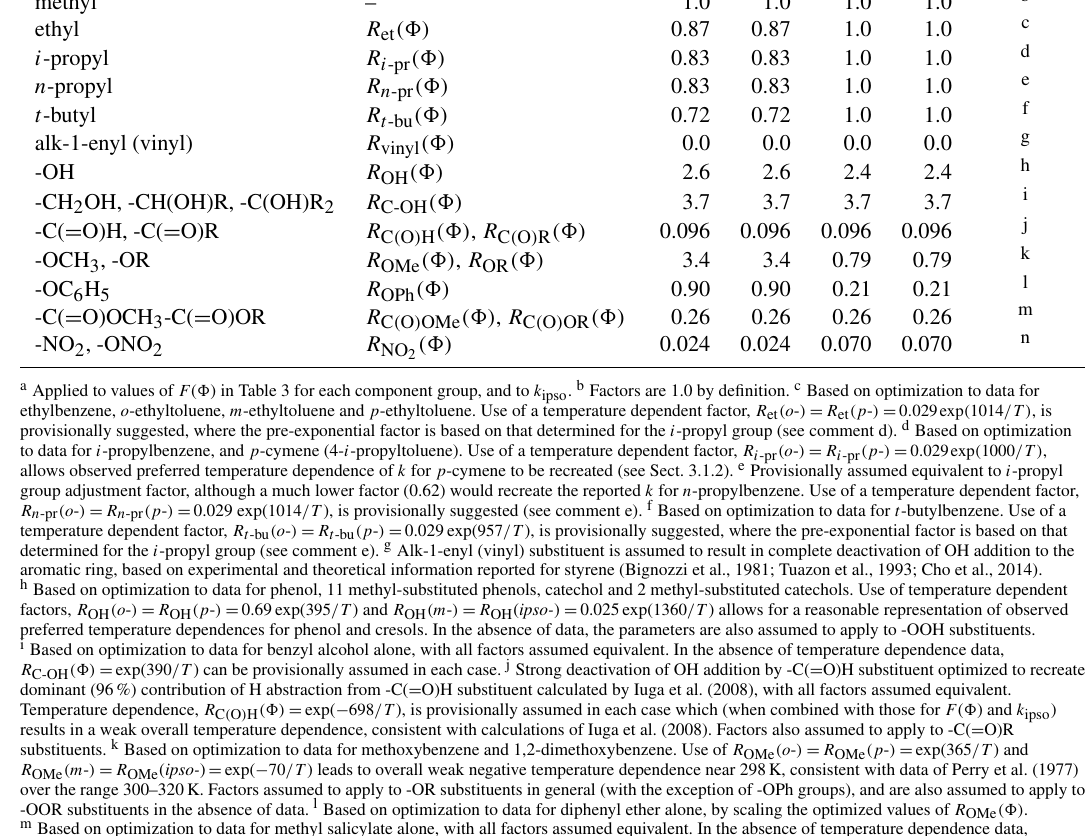
Table 6. Substituent adjustment factors, R ( (cid:56) ), relative to the F ( (cid:56) ) values shown for methyl substituents in Table 3 and k ipso in Table 2. Tabulated values are applicable to 298K, with suggested temperature dependences provided in the comments a . Substituent Parameter Position of substituent Comment